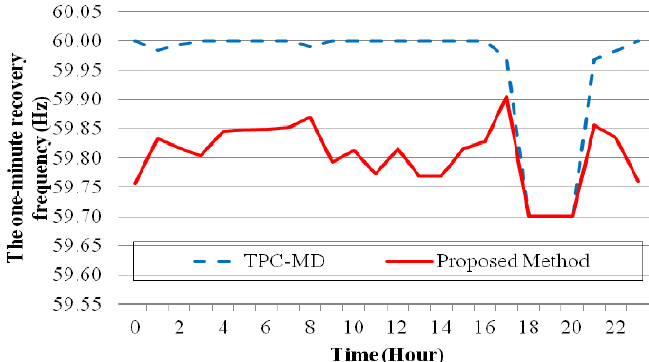
Figure 4. The one-minute recovery frequency following the largest on-line generator outage on weekend comparison between the proposed method and